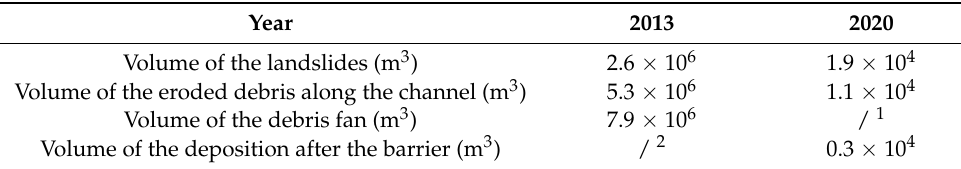
Table 1. The volumes of landslides, eroded debris along the channel, debris fan, and the deposition after the barrier.